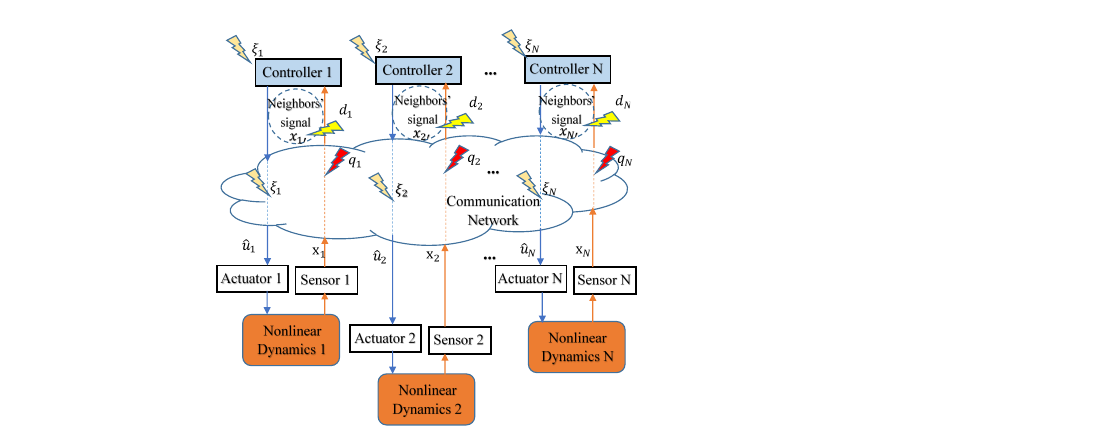
Figure 3. The deception attack in cyber-physical system. According to the secific location of the deception attack, the figure shows three different deception attacks, where ξ i represents the deception attack on the controller itself or controller–actuator channel (tampering with the control signal u i ), q i represents the deception attack on the sensor–controller channel (tampering with the output signal y i ), and d i represents the deception attack on the transmission channel of the neighbor agents (tampering with the state value x j with j ∈ N i